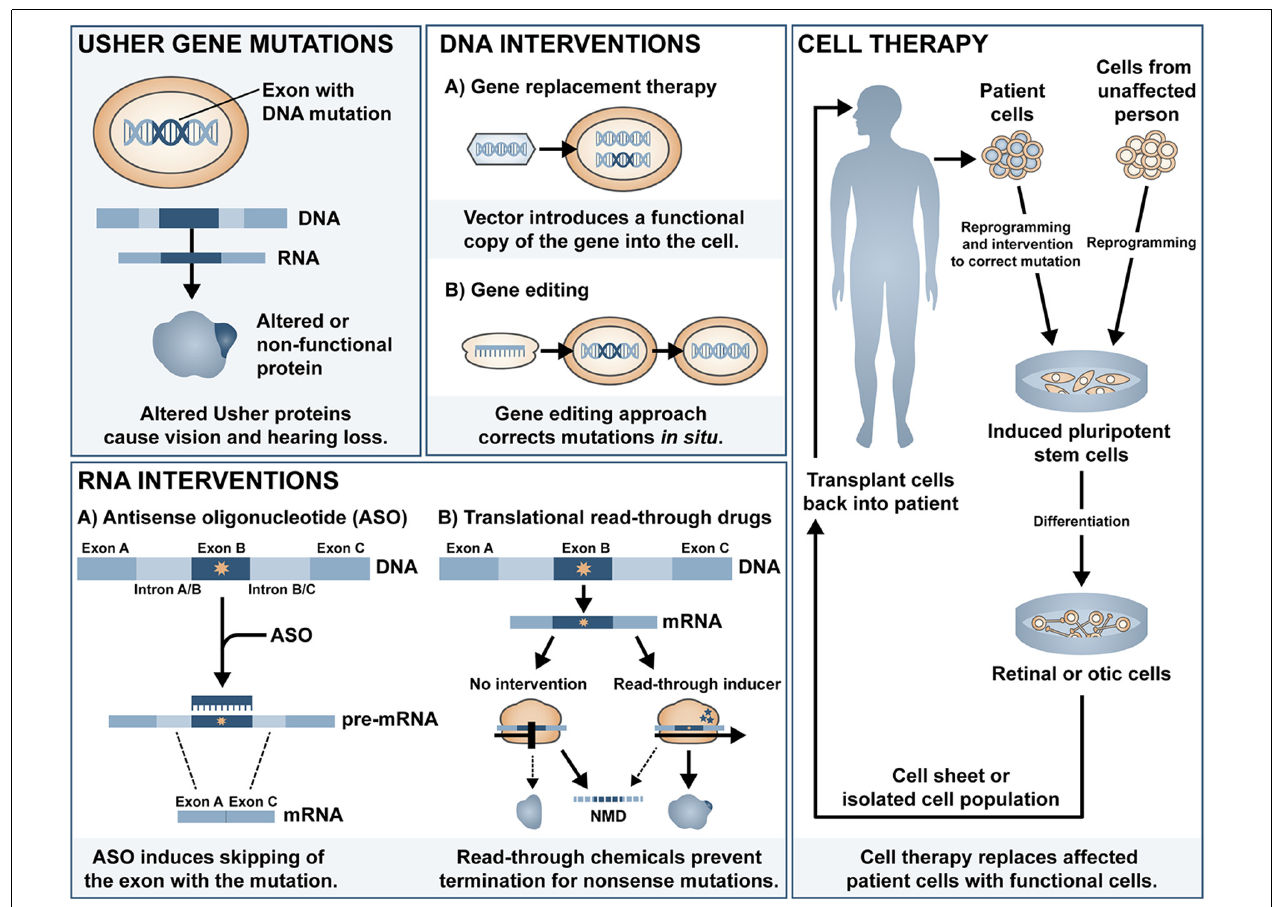
FIGURE 1 | Overview of the different therapeutic approaches for Usher